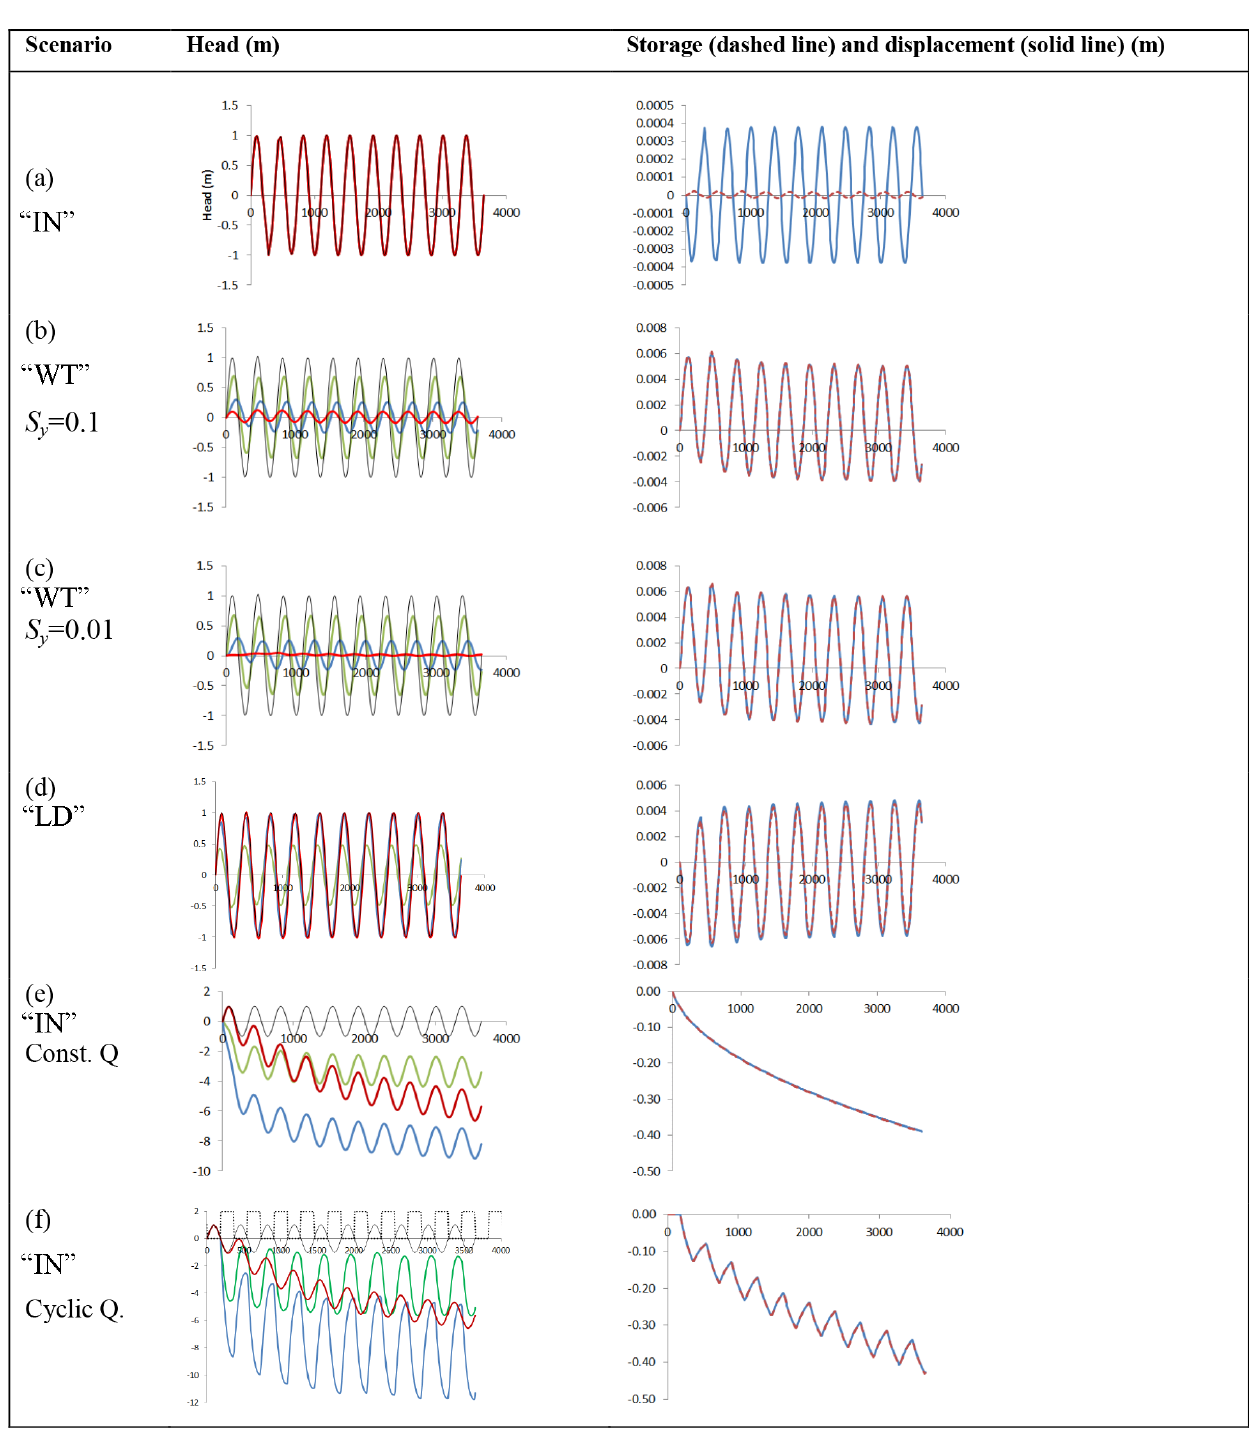
Figure 4. 1-D model simulations for the GBM environment, showing results for the scenarios (a) “IN”, (b) “WT” ( S y = 0 . 1), (c) “WT” ( S y = 0 . 01), (d) “LD”, (e) “IN” with constant pumping, and (f) “IN” with cyclic pumping (see text for explanation). The x axis is time in days, shown to 10 years (i.e. 3650d). The amplitudes reported in the text are calculated from the max–min of the last annual cycle. Left: the y axis is head, in metres (m). The surface head and/or mechanical load boundary conditions (black line) are expressed as equivalent metre head (for the WT condition the unit variation of head is given and the S y variation in mechanical load is not shown); results are in green (30m depth), blue (100m depth), and red (300m depth) in all cases. For panel (a) results are co-linear at all depths; for panel (f) the intermittent pumping is shown as off/on by the square-wave dotted line. Right: the y axis has dimension of length, in metres (m), showing changes in storage (dashed red line) and surface displacement (solid blue line) for each